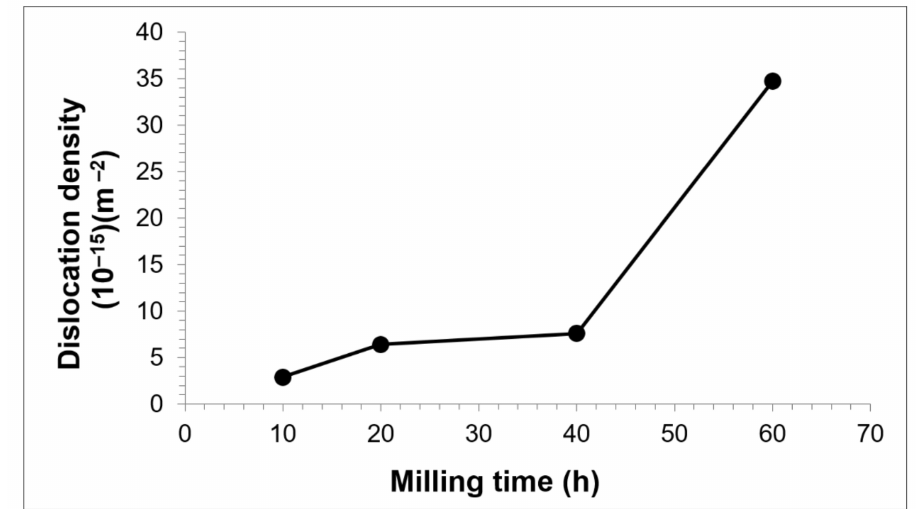
Figure 3. Dislocation density of as-milled Cu-W-C powder at various milling